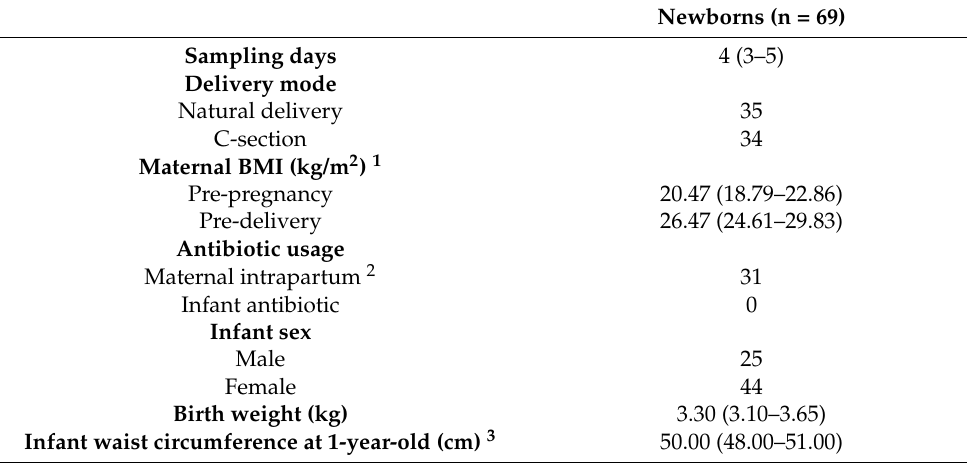
Table 1. Characteristics of the mothers and infants included in the